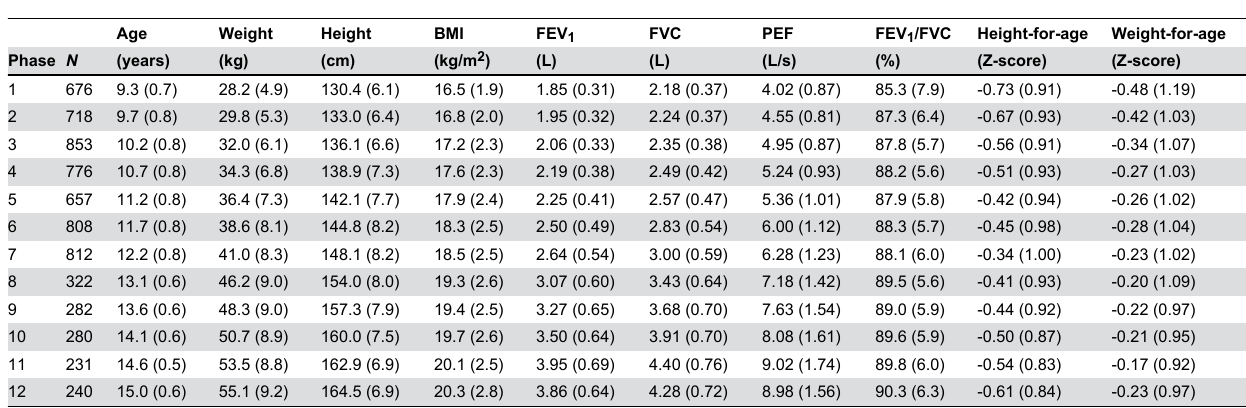
Table 1. Main characteristics of the boys studied (means and SD).